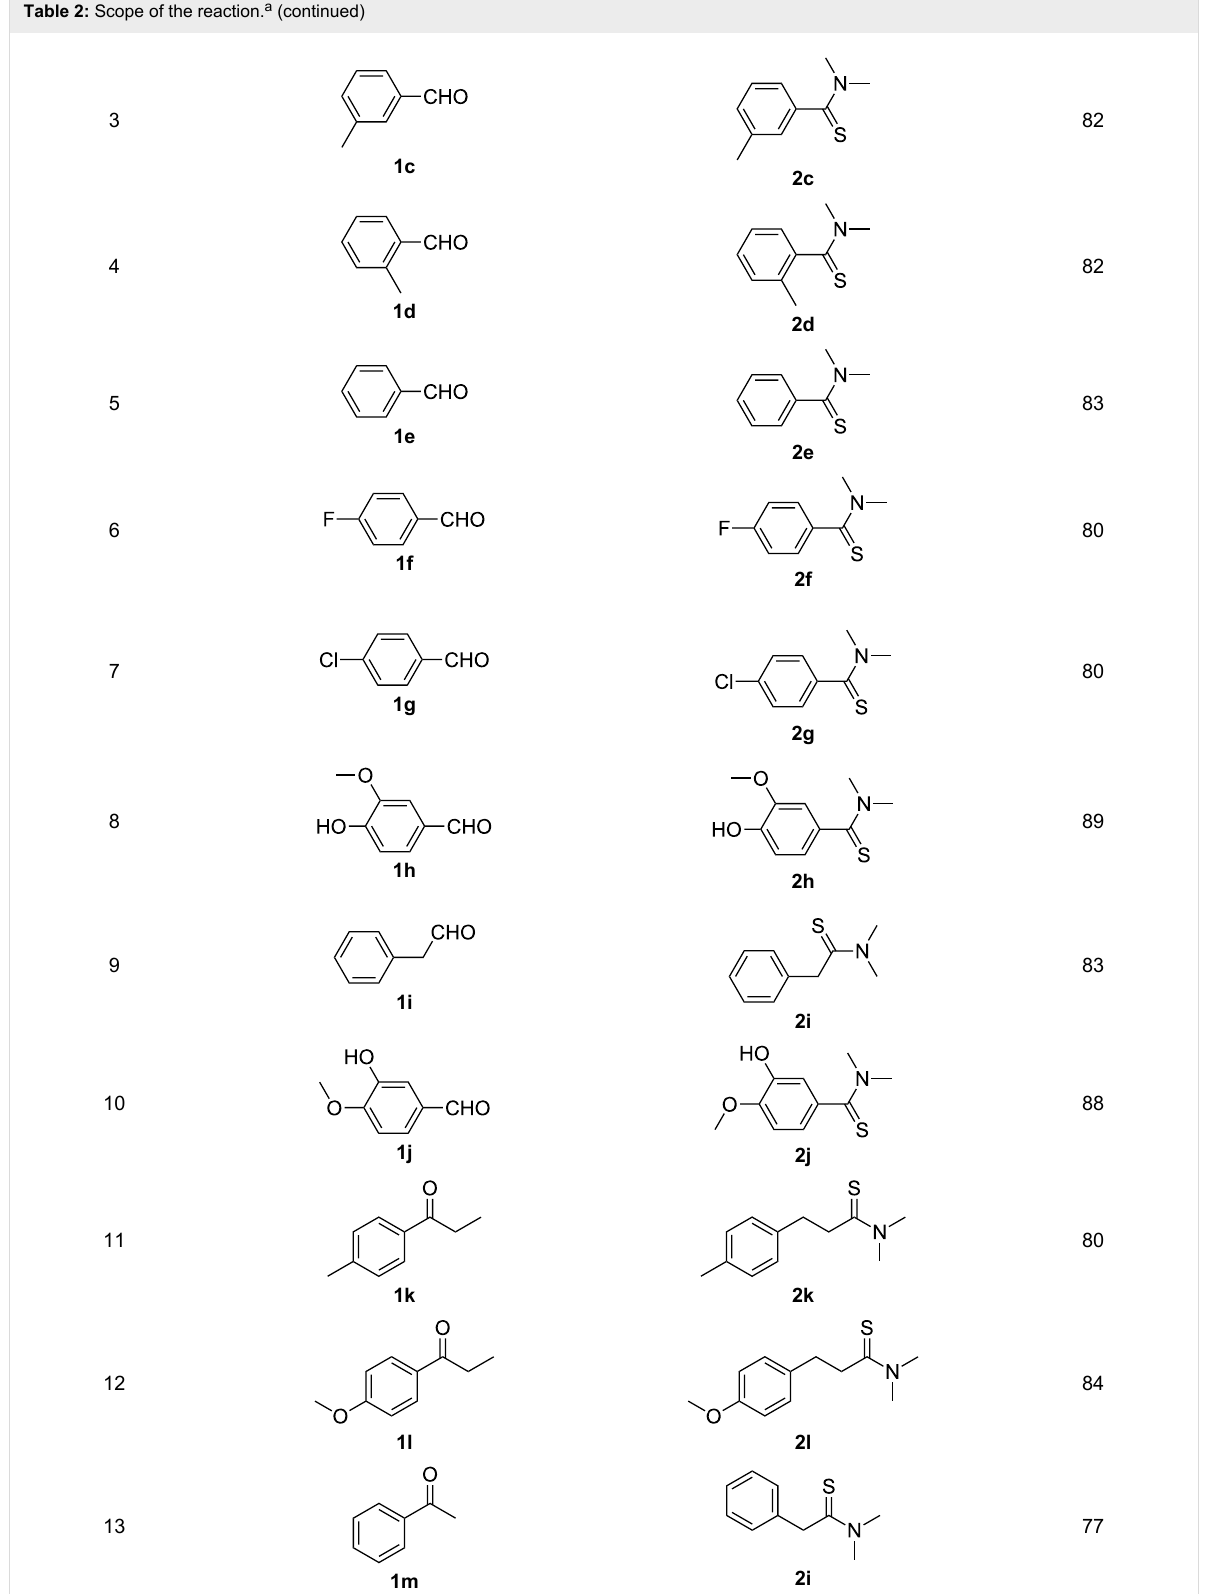
Table 2: Scope of the reaction. a